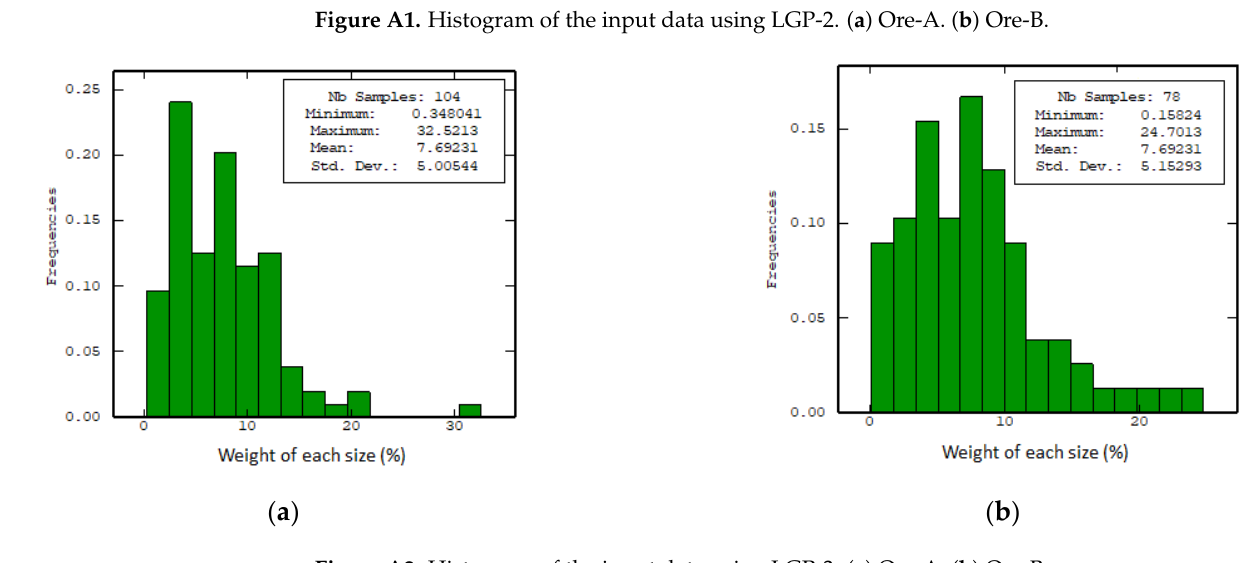
Figure A2. Histogram of the input data using LGP-3. ( a ) Ore-A. ( b ) Ore-B.